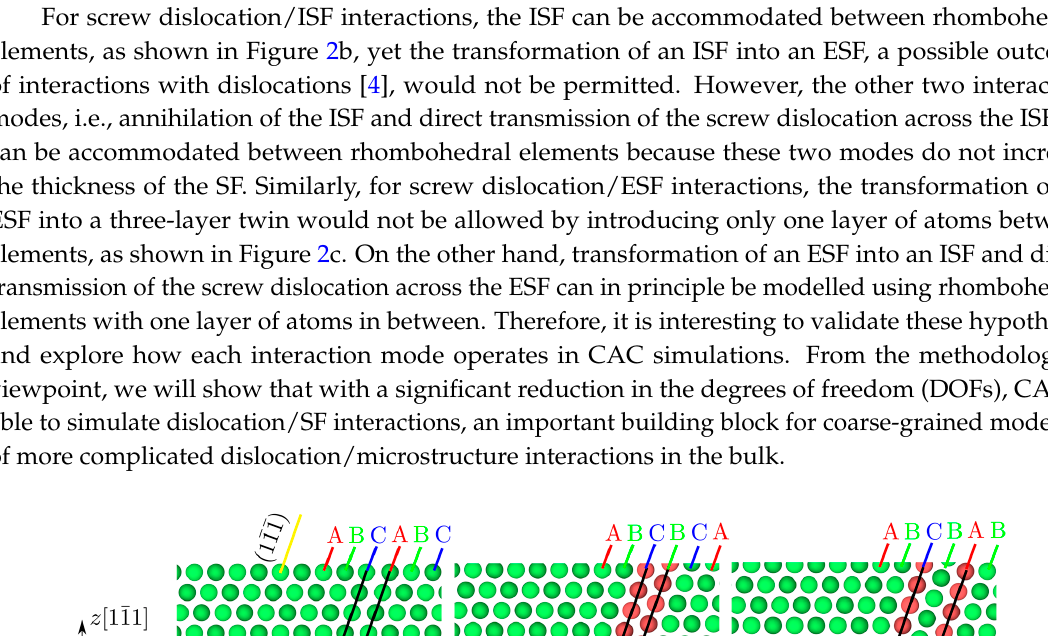
(cid:0) (cid:1) 111 atomic plane is introduced